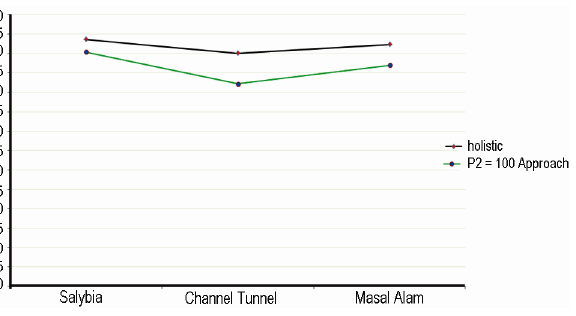
Fig. 5. Comparison between average holistic and decomposed evaluation